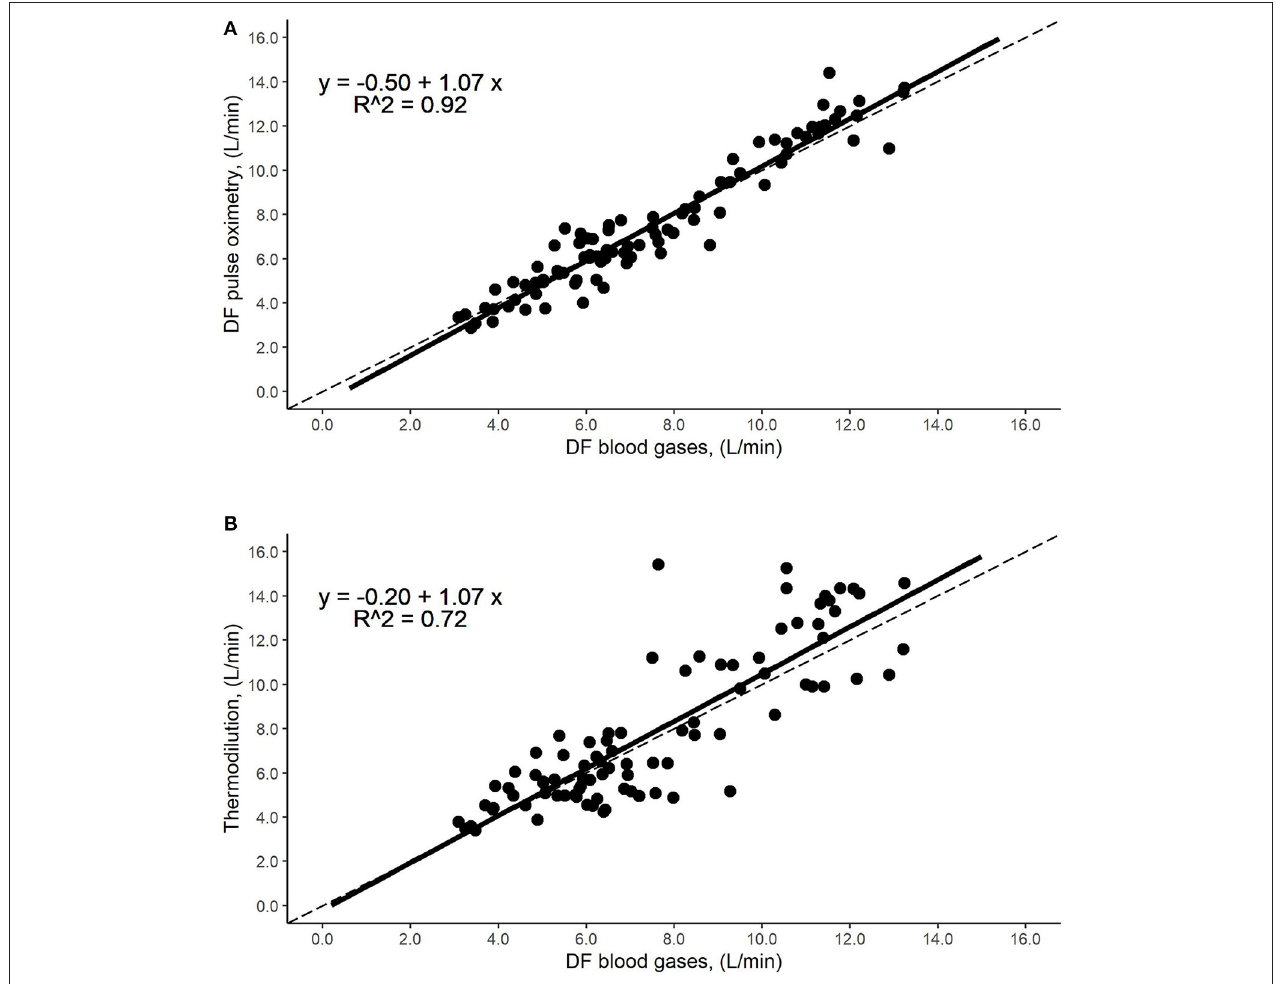
FIGURE 1 | Identity plot of cardiac output (CO) measurement methods. Relationship by regression, such as data points from rest and end-exercise; the dashed line represents the line of equality. The black solid line represents the regression line, while the dots stand for the corresponding measurements. (A) Direct Fick using pulse oximetry (DFp) vs. direct Fick using blood gases (DF): The regression line shows an R 2 of 0.92, a slope of 1.07 with an intercept of − 0.50 L/min and no displacement over the line of identity over a broad range of CO values. (B) Intermittent thermodilution (TD) vs. direct Fick using blood gases (DF): The regression line shows an R 2 of 0.72, a slope of 1.07 with an intercept of − 0.20 L/min and no displacement over the line of identity over a broad range of CO